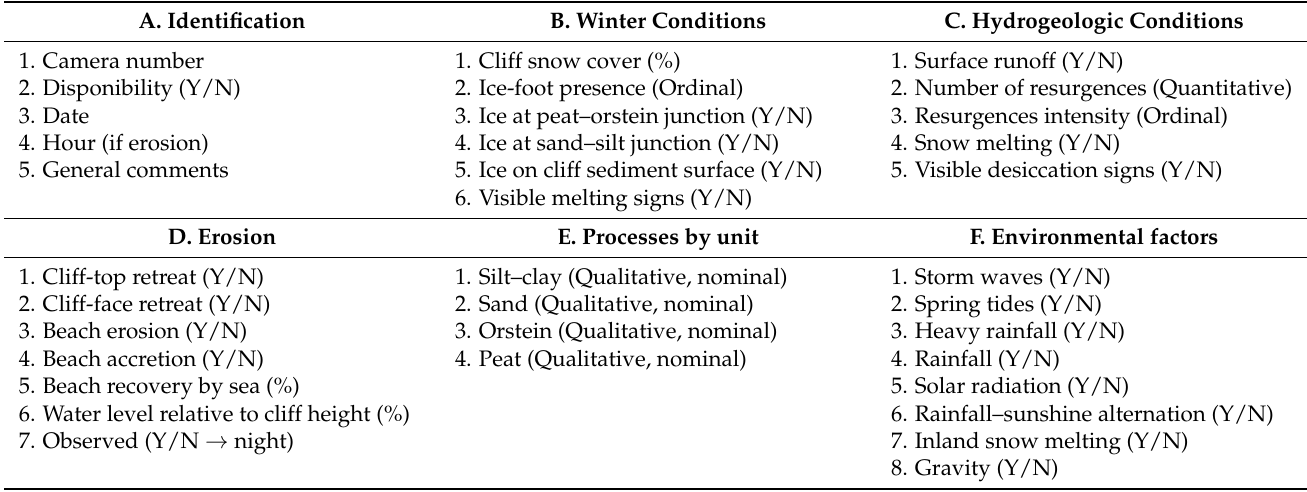
Table 3. Environmental variables observed on cameras.